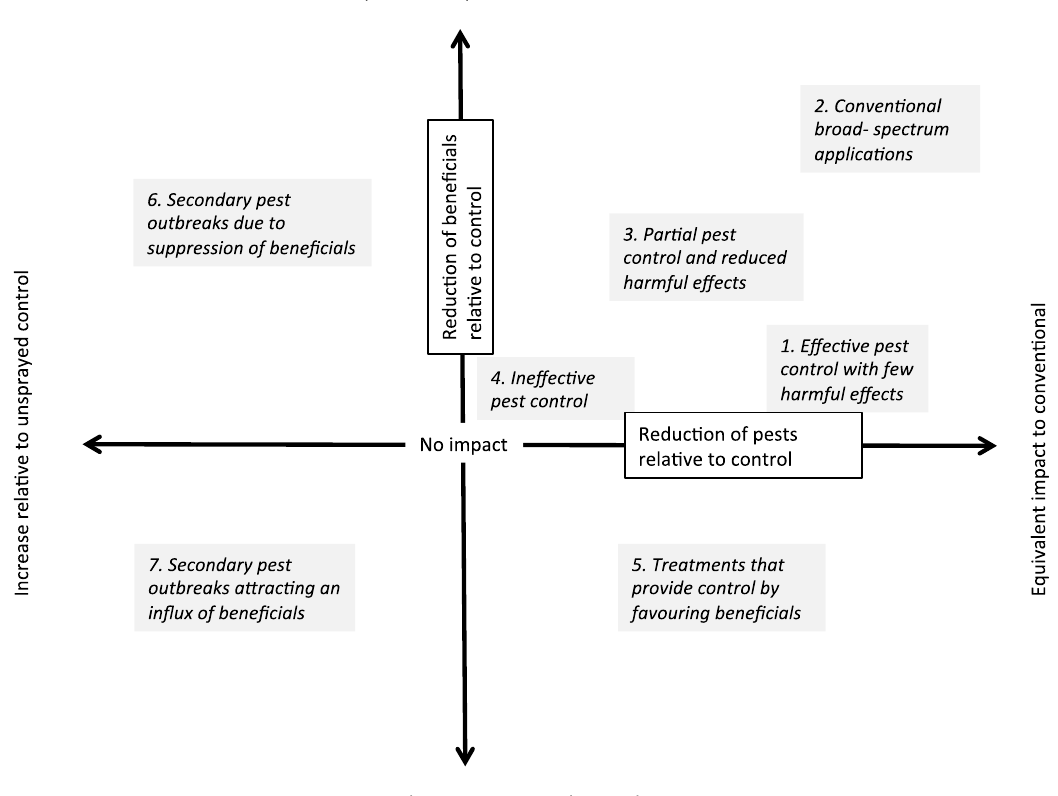
Figure 1. A framework for assessing the impact of new chemical applications on pest and beneficial invertebrates relative to a conventional chemical treatment and unsprayed treatment. The x-axis represents the effectiveness of the application for controlling a target pest relative to a control treatment. At the intersection with the y-axis there is no control of the pest ( i.e. , pest numbers are equivalent to an unsprayed control). The y-axis represents the relative reduction of the application on beneficials relative to the unsprayed control. Ideally, new applications will be less harmful but still provide control (1) at similar levels to the conventional treatment, (2) whereas many new chemicals are expected to provide reduced levels of control but also reduced levels of harm (3). Pest numbers can also increase (to the left of the origin) if there are idiosyncratic effects